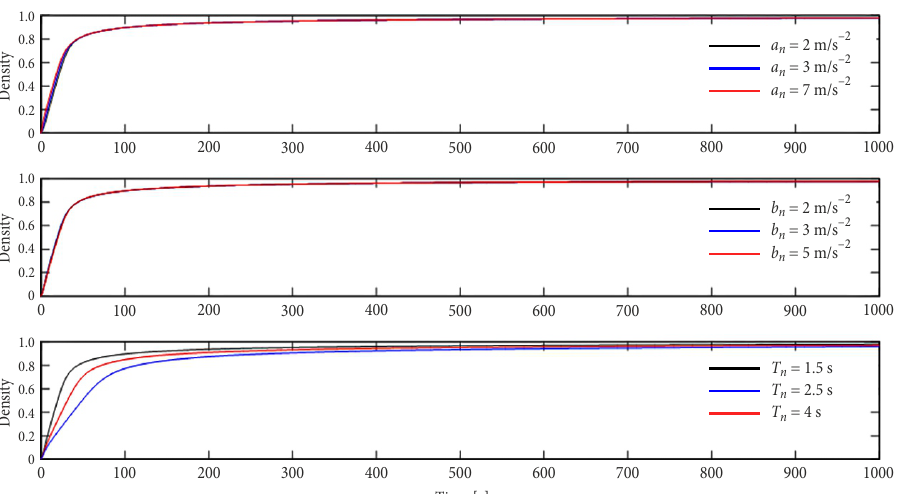
Fig. 7. Velocity for different a n , b n and T n